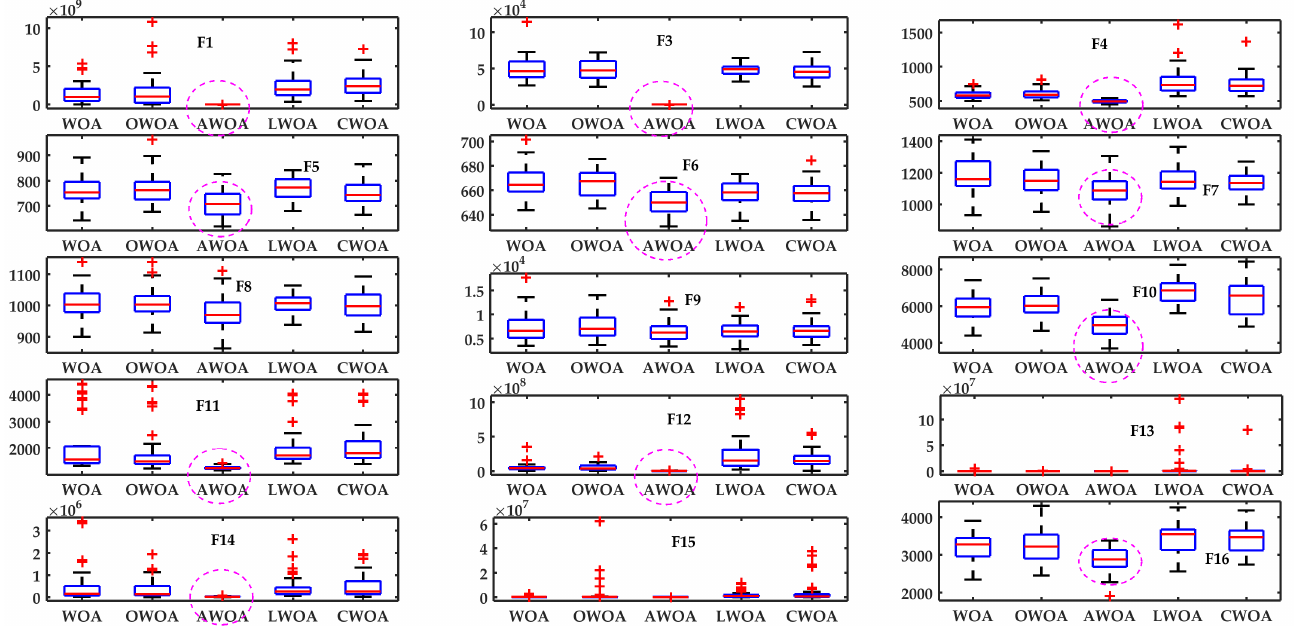
Figure 9. Boxplot analysis of the 10D functions of Benchmark Suite 2.